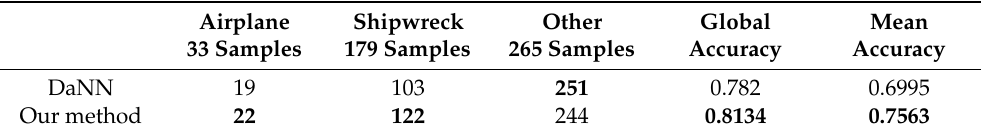
Table 2. Accuracy and total correct classifications (the number of test samples is also shown. We regard only true positives as correct, and the best results are marked in